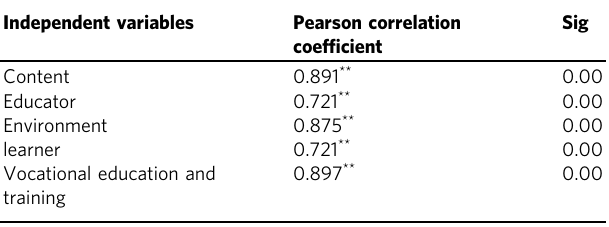
Table 8 The correlation between research variables and the